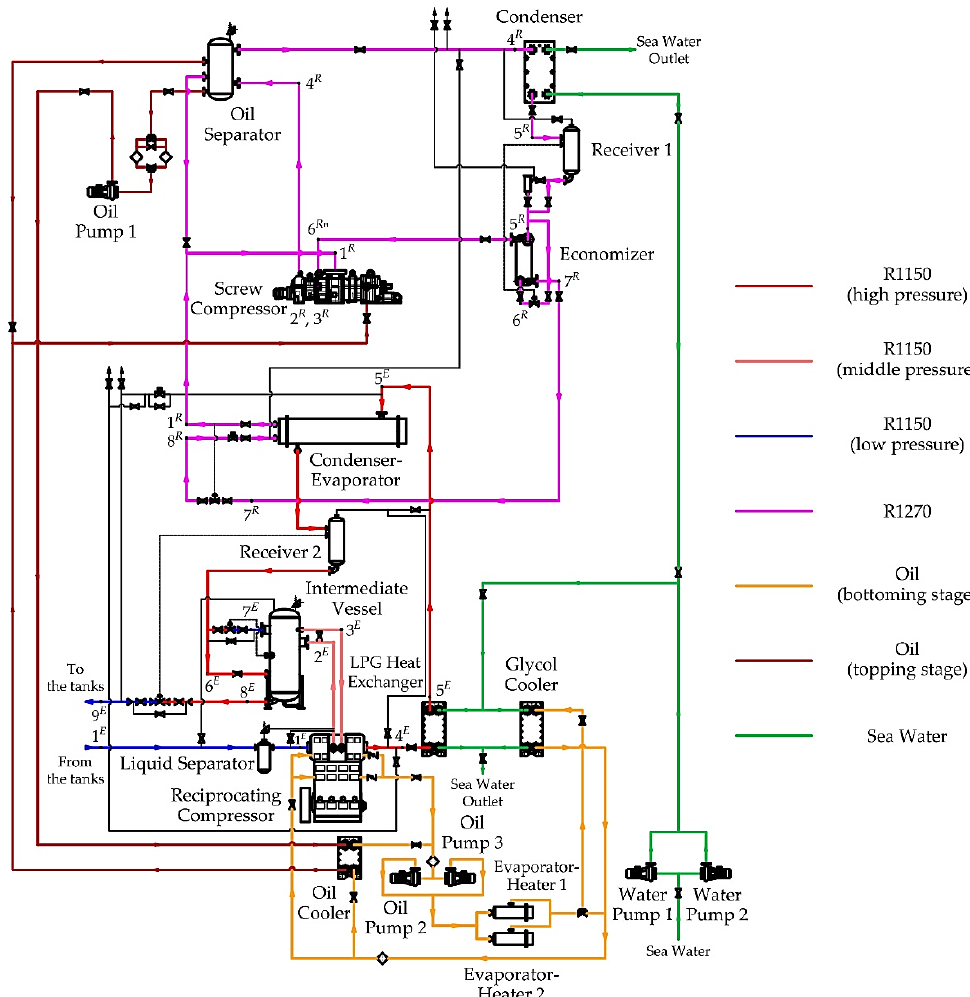
Figure 1. Flow diagram of the reliquefication system.